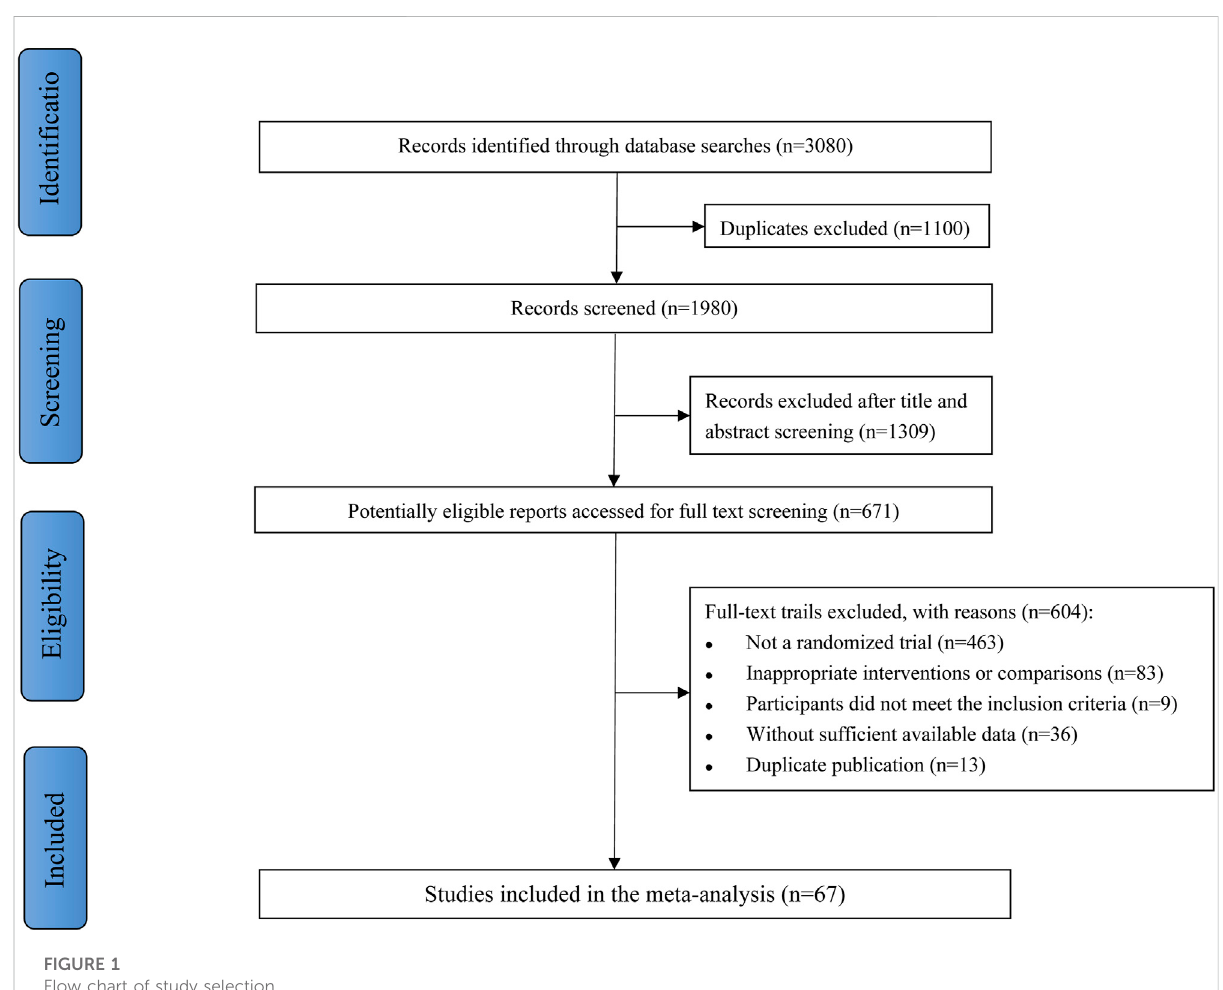
FIGURE 1 Flow chart of study